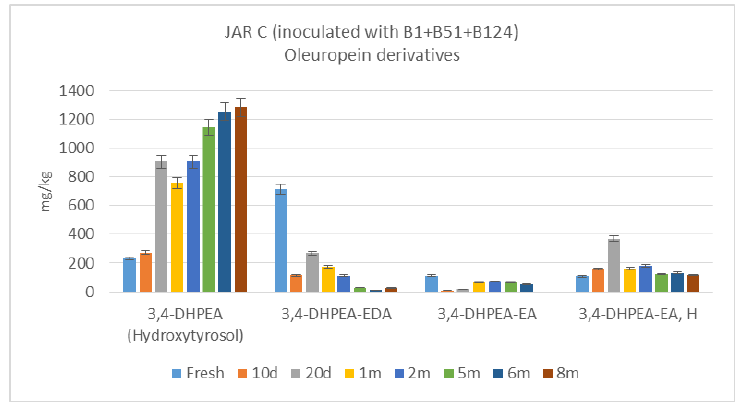
Figure 7. Oleuropein derivatives in the olive flesh during the fermentation.